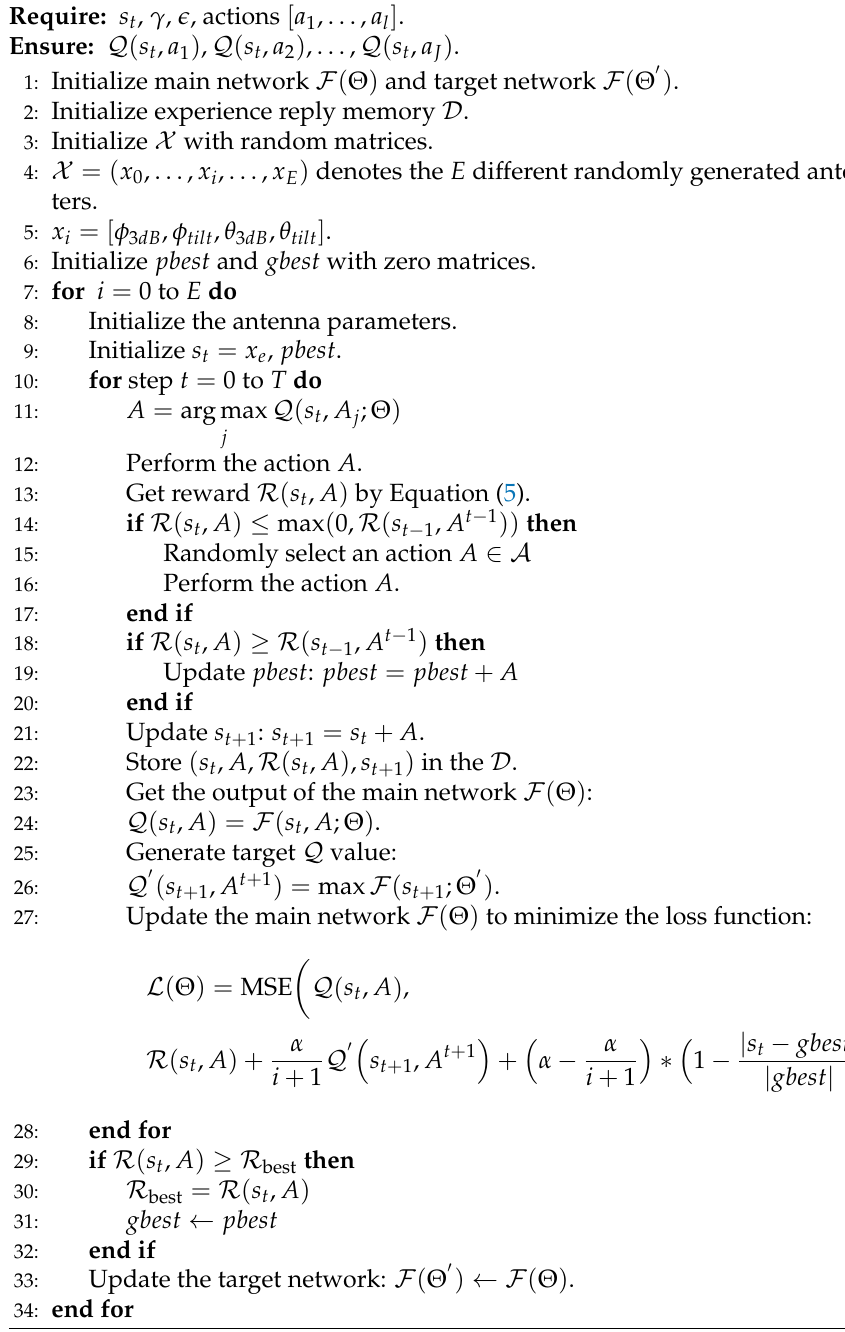
Algorithm 4 Deep Reinforcement Learning Evolution